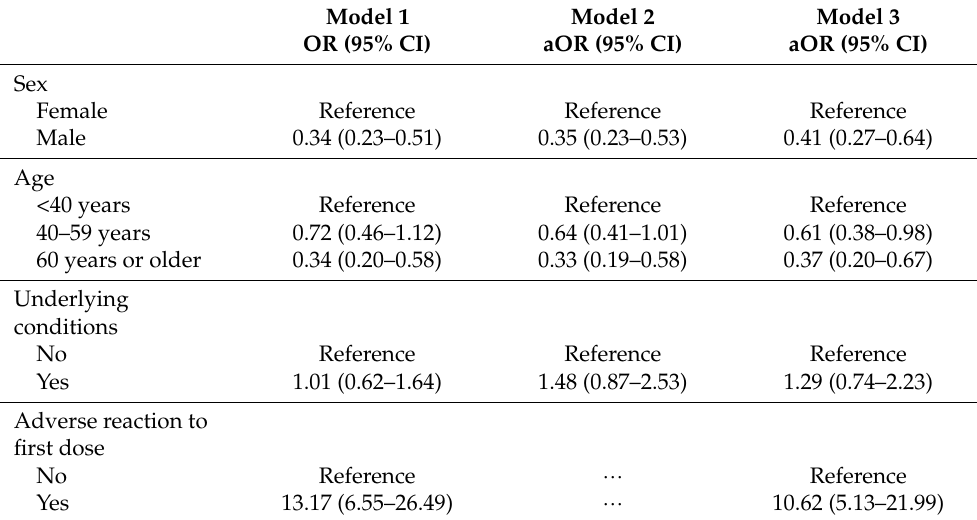
Table 4. Factors associated with systemic adverse reactions after the second dose of COVID-19 mRNA